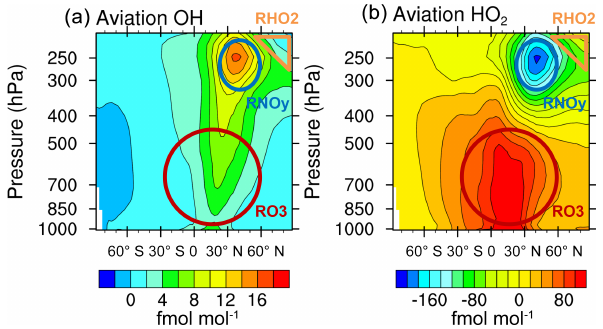
Figure 7. Annual mean absolute contribution [fmolmol − 1 ] of avi- ation to the simulated OH (a) and HO 2 (b) volume mixing ratios. The regions RO 3 , RNO y , and RHO 2 are characterised by distinct different chemical response to aviation emissions as described by Grewe et al. (2002) (see text for further